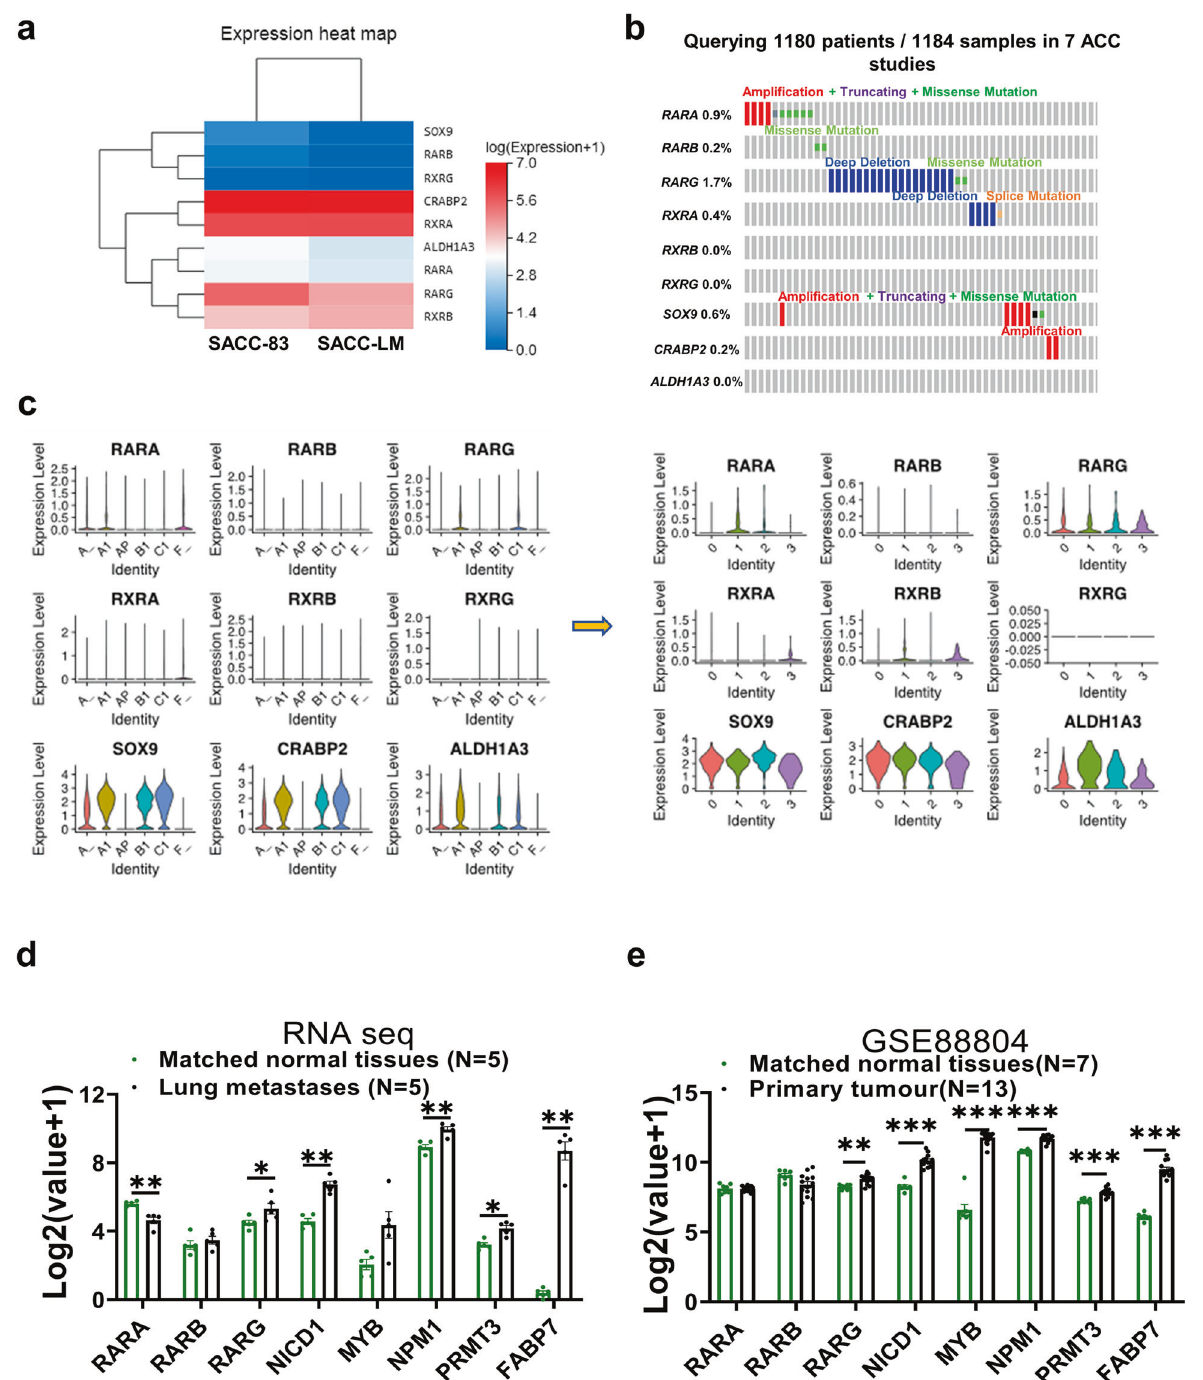
Fig. 7 Lung metastasis in patients with SACC might partly be caused by insuf fi cient RA signaling. a Heatmap of the expression of genes related to RA signaling in SACC-83 cells and SACC-LM cells, as determined by RNA-seq. b Mutation analysis of RA signaling molecules from the cBioPortal database in 1184 samples from 1180 patients based on seven ACC studies. c Violin plot of scRNA-seq analysis of the expression levels of RA signaling molecules from six tissues of two patients and four subtypes of cluster 10. d , e Statistical analysis of the mRNA levels of MYB, NICD1, FABP7, NPM1, PRMT3 , and RARs in fi ve lung metastasis samples or 13 primary tumor samples (GSE 88804) versus matched normal tissue samples. The p values were calculated using the two-tailed Mann – Whitney U -test. Data were presented as the mean ± SEM. p < 0.05 (*), p < 0.01 (**), and p < 0.001